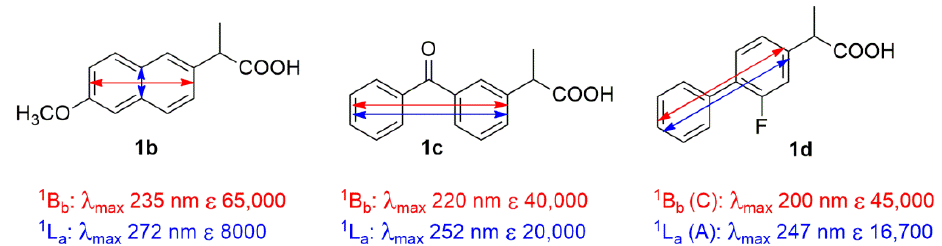
Figure 5. Main UV transitions of naproxen ( 1b ), ketoprofen ( 1c ) and flurbiprofen ( 1d ) in the 200 – 300 nm spectral range.